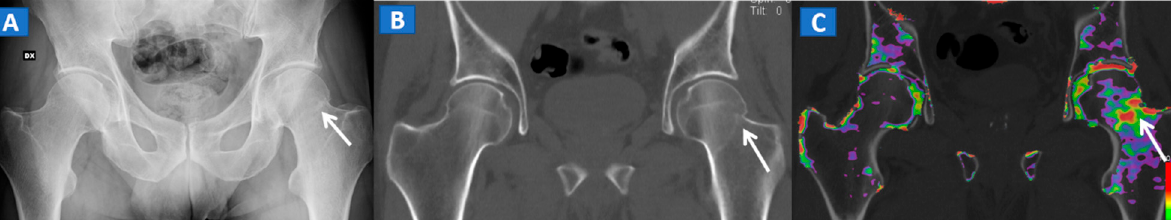
Figure 3. A 51-year-old male with a non-displaced left cervical fracture. On the coronal standard radiograph ( A ), a meshed fracture is suspected on the left side because of an apparent cortical irregularity (arrow). On the corresponding standard reconstructed 1 mm CT image ( B ), a subtle cortical irregularity is confirmed (arrow). On the corresponding DECT reconstructed coronal 1 mm image ( C ), severe BME clearly delineates the fracture line (arrow), which is surrounded by a mild oedema halo involving the trochanteric region.